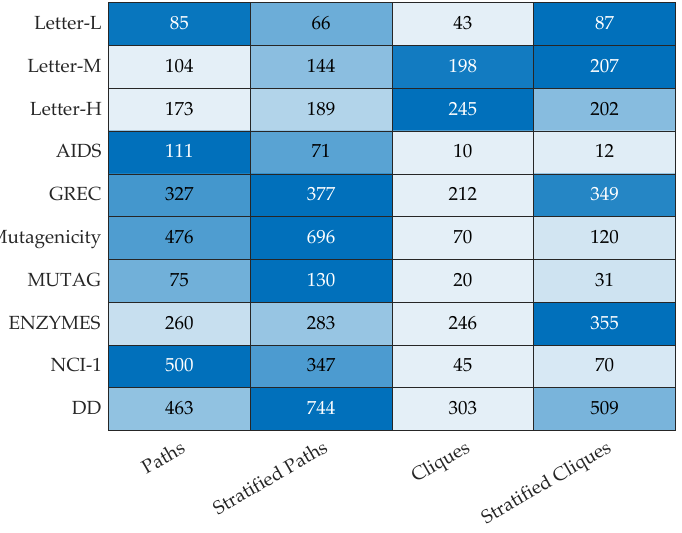
Figure 5. Size of the alphabet before feature selection. Table 3. Comparison against state-of-the-art graph classification system in terms of classification